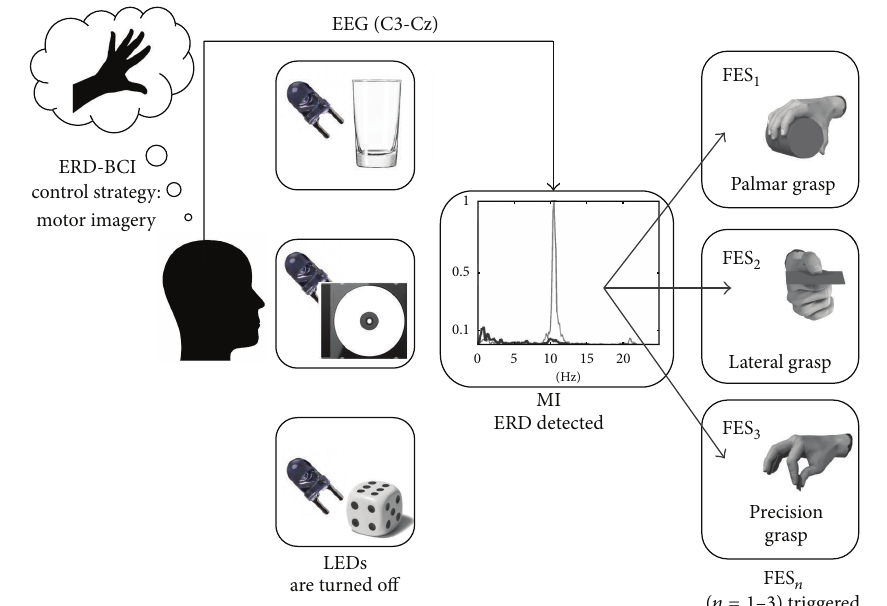
Figure 2: Block scheme of stage II of the hybrid BCI operation, ERD-BCI. At the beginning of stage II, all three LEDs are turned off and the subject imagines the adequate grasp for the object selected in the previous stage. If ERD is detected in the EEG (C3-Cz), previously selected FES pattern is triggered. The graph represents: EEG power spectrum during rest and EEG power spectrum during MI, normalized by the peak value (thin and thick curves,